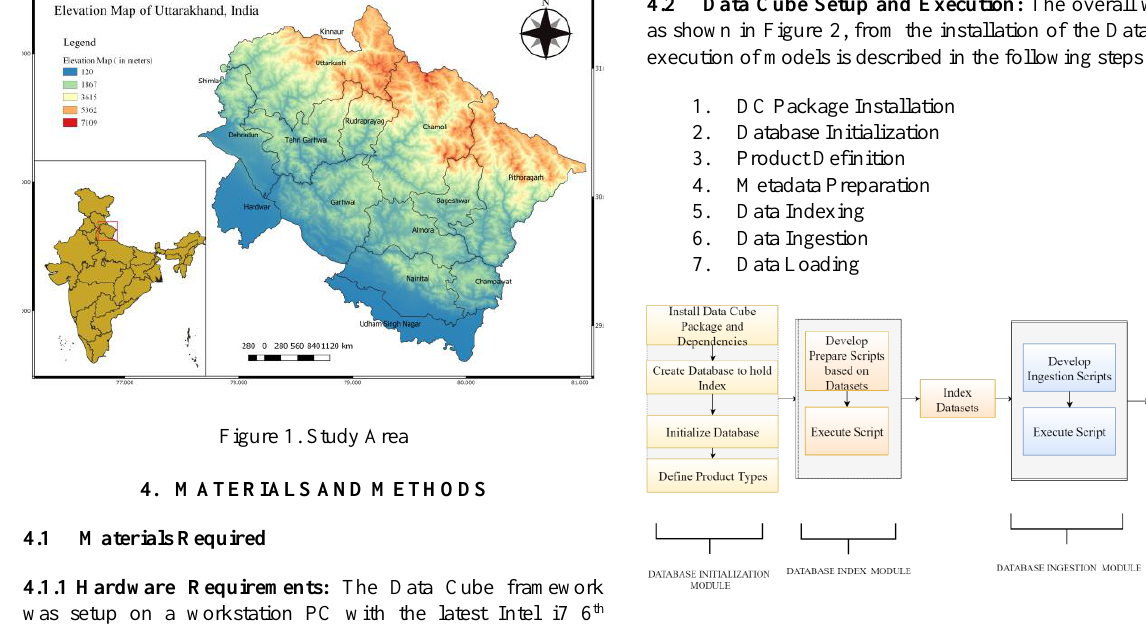
Figure 2. Data Cube